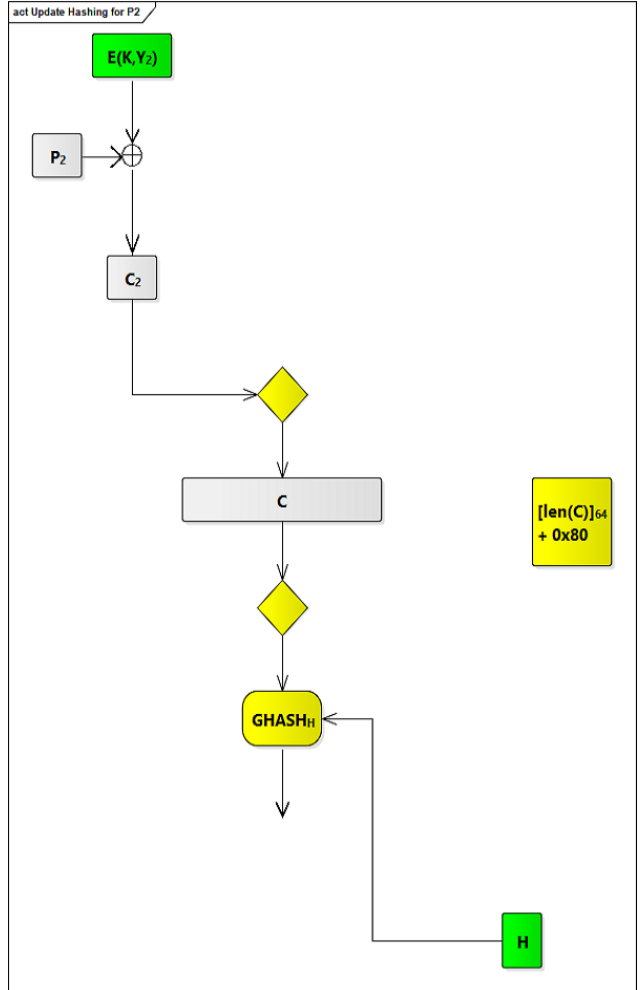
Figure 12. Update hashing for P 2